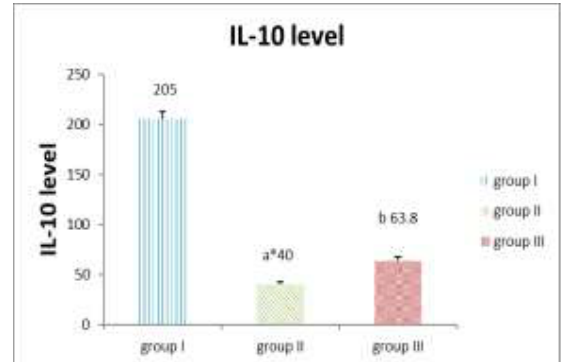
Figure 2. Effect of vinpocetine on IL-1β levels in brain tissue homogenate after IP injection of lead acetate in rats.